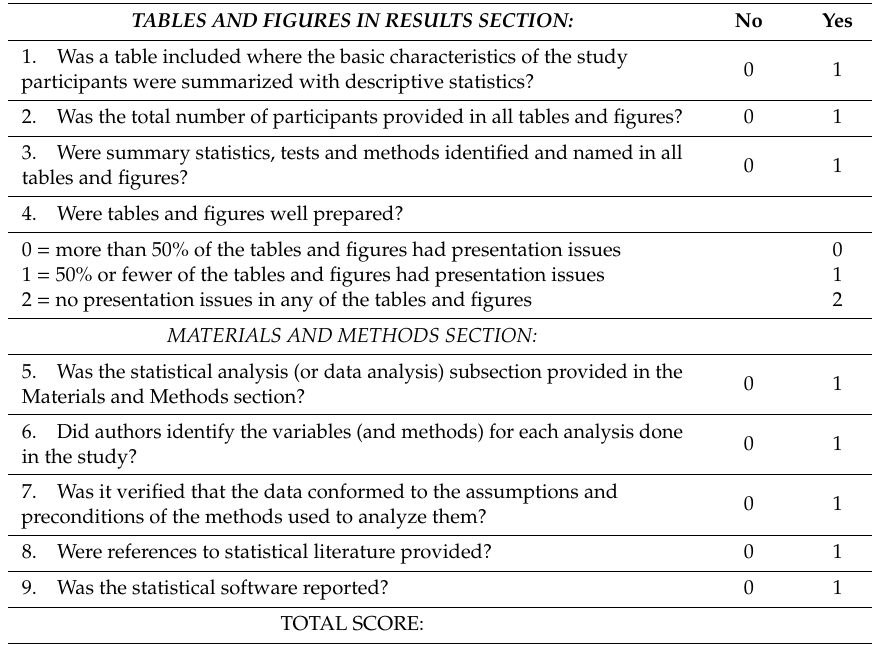
Table 1. Statistical reporting and data presentation evaluation